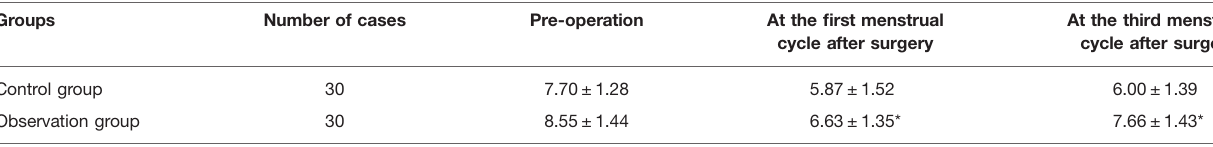
TABLE 3 | Comparison of the AFC between the two groups of patients. Groups Number of cases Pre-operation At the fi rst menstrual